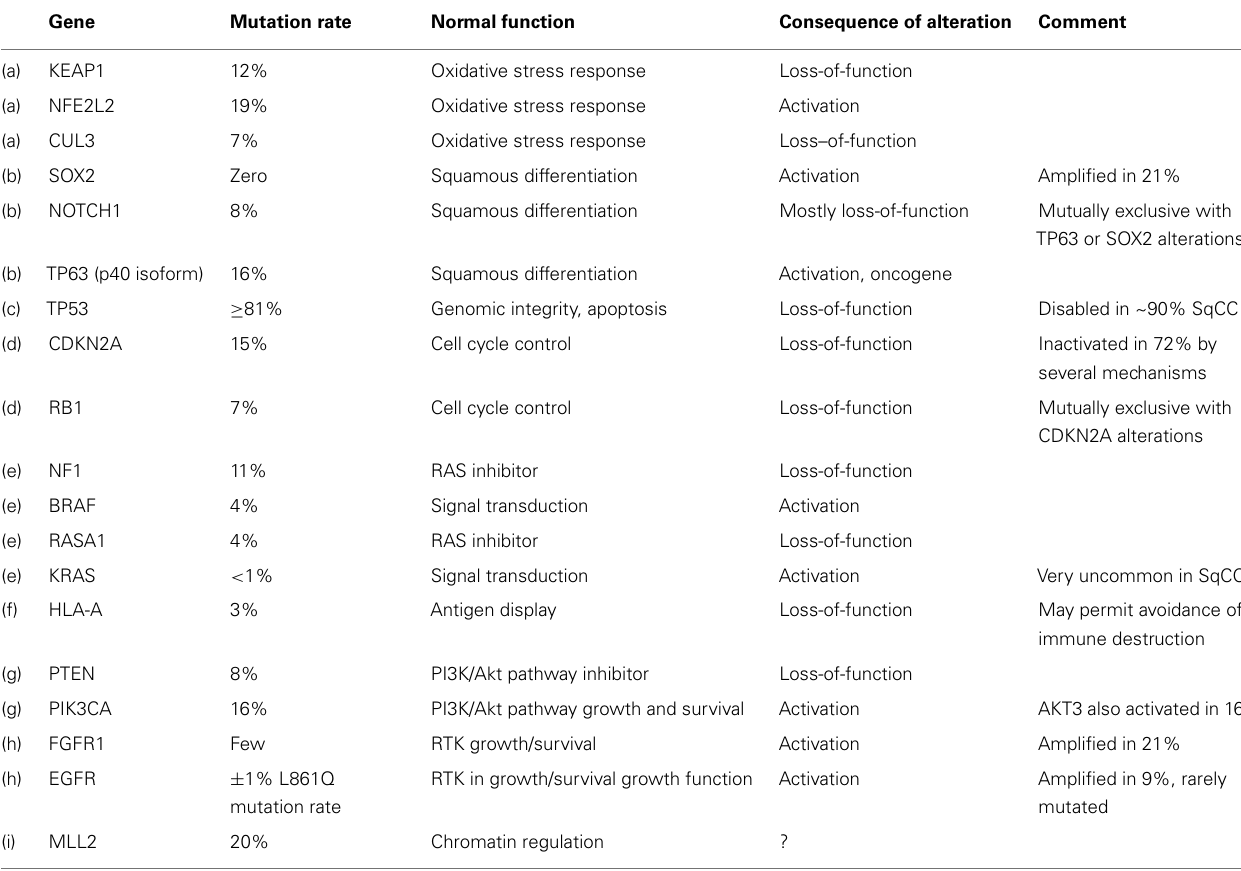
Table 1 | Selected genomic alterations in SqCC